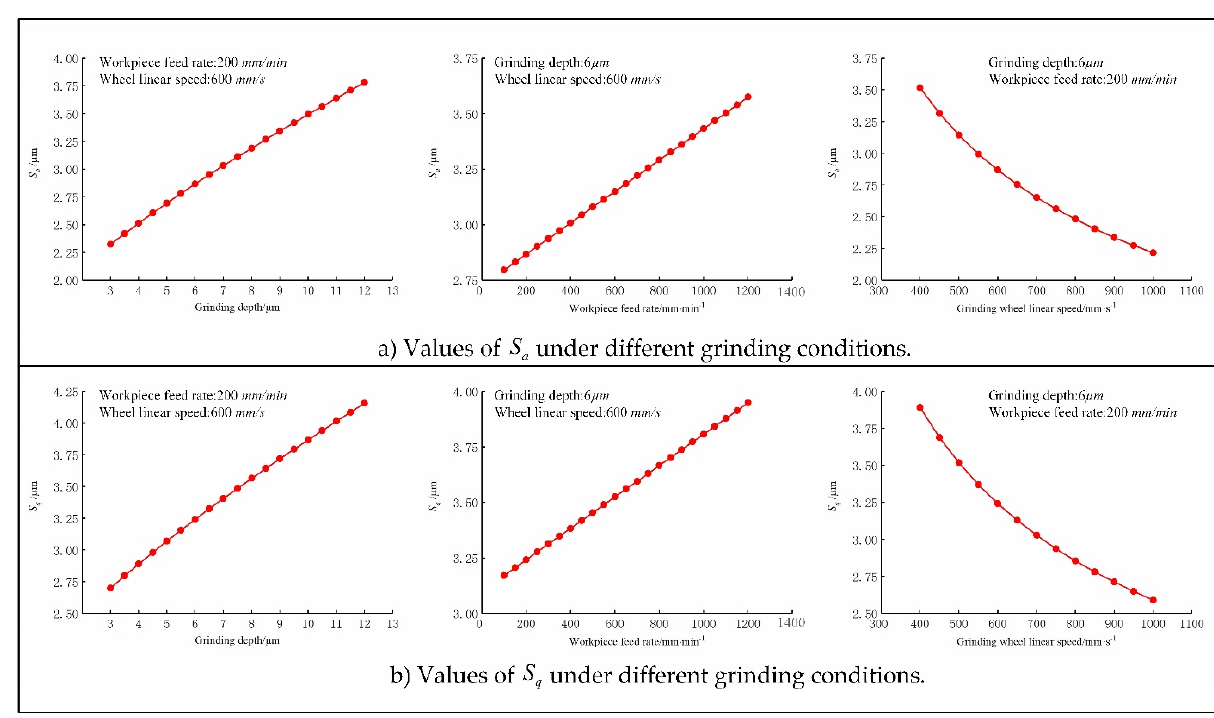
S S under different grinding and q